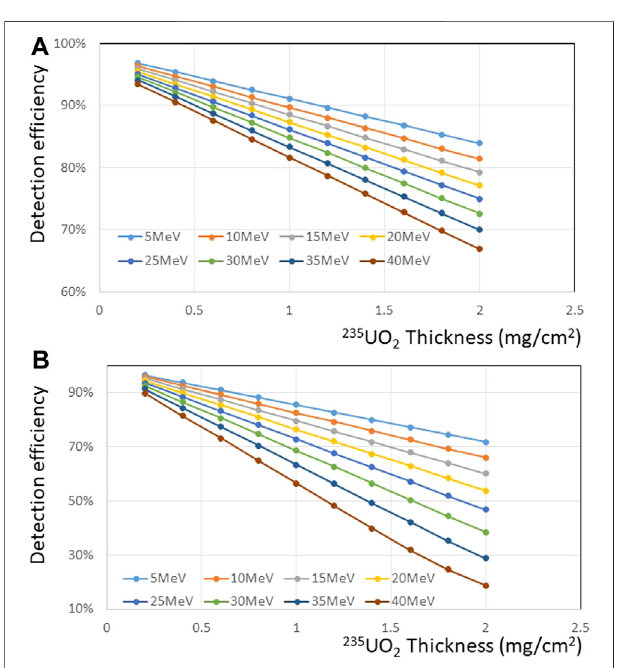
FIGURE 14 | Detection ef fi ciency as function of the 235 UO 2 target layers of 0.2 – 2 mg/cm 2 thickness. (A) for 84 Ge, (B) for the complementary 150